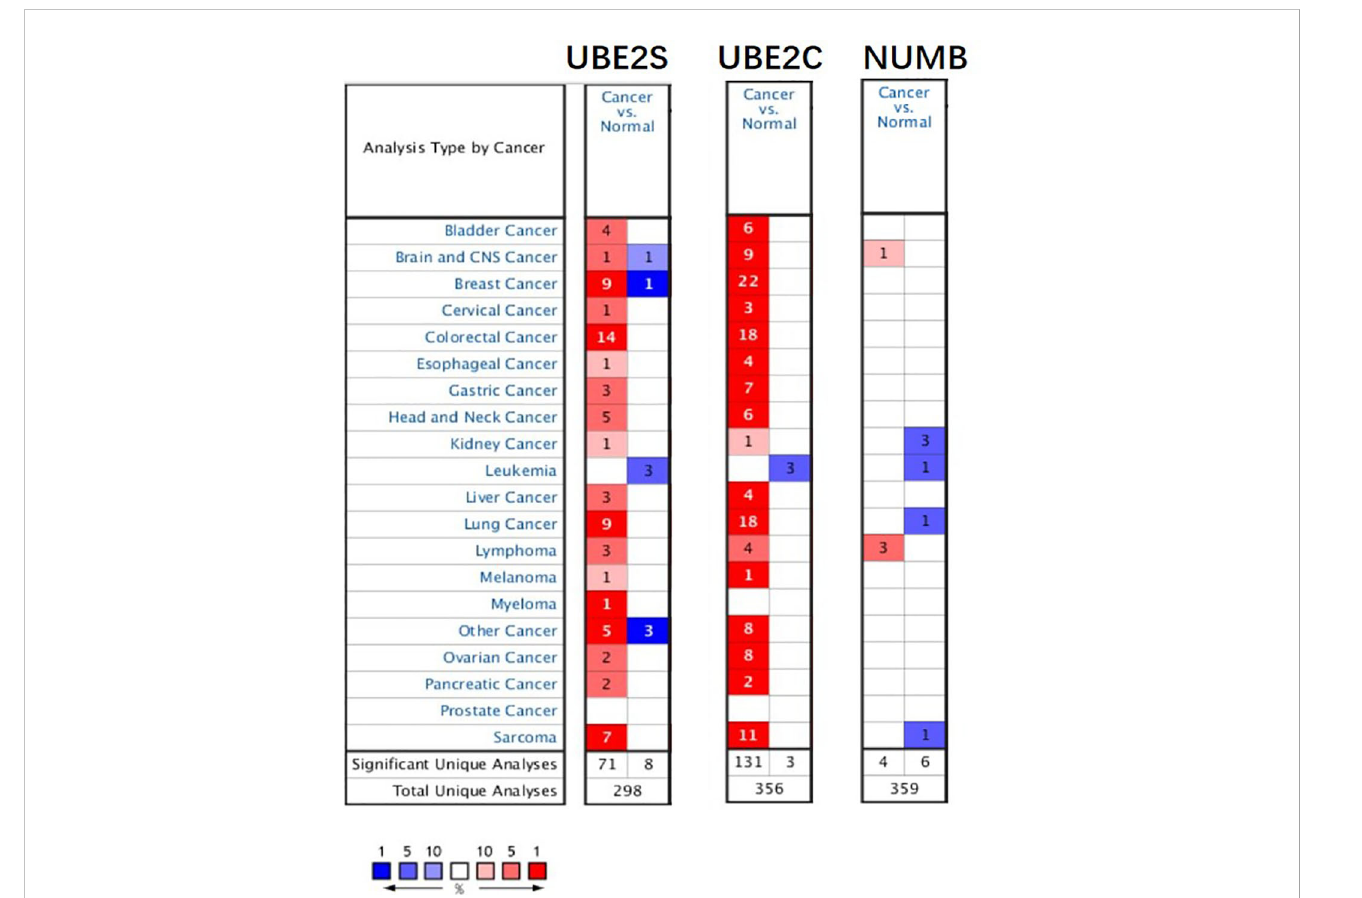
FIGURE 1 The expression of UBE2S, UBE2C, and Numb in different types of tumors ( Oncomine database). In the diagram, the threshold parameters were set as follows: p-value of 0.01, fold change of 2, and gene rank of 10% for the cell color analysis within the cell. In each form, the number represents the number of analyses that meet the threshold across various